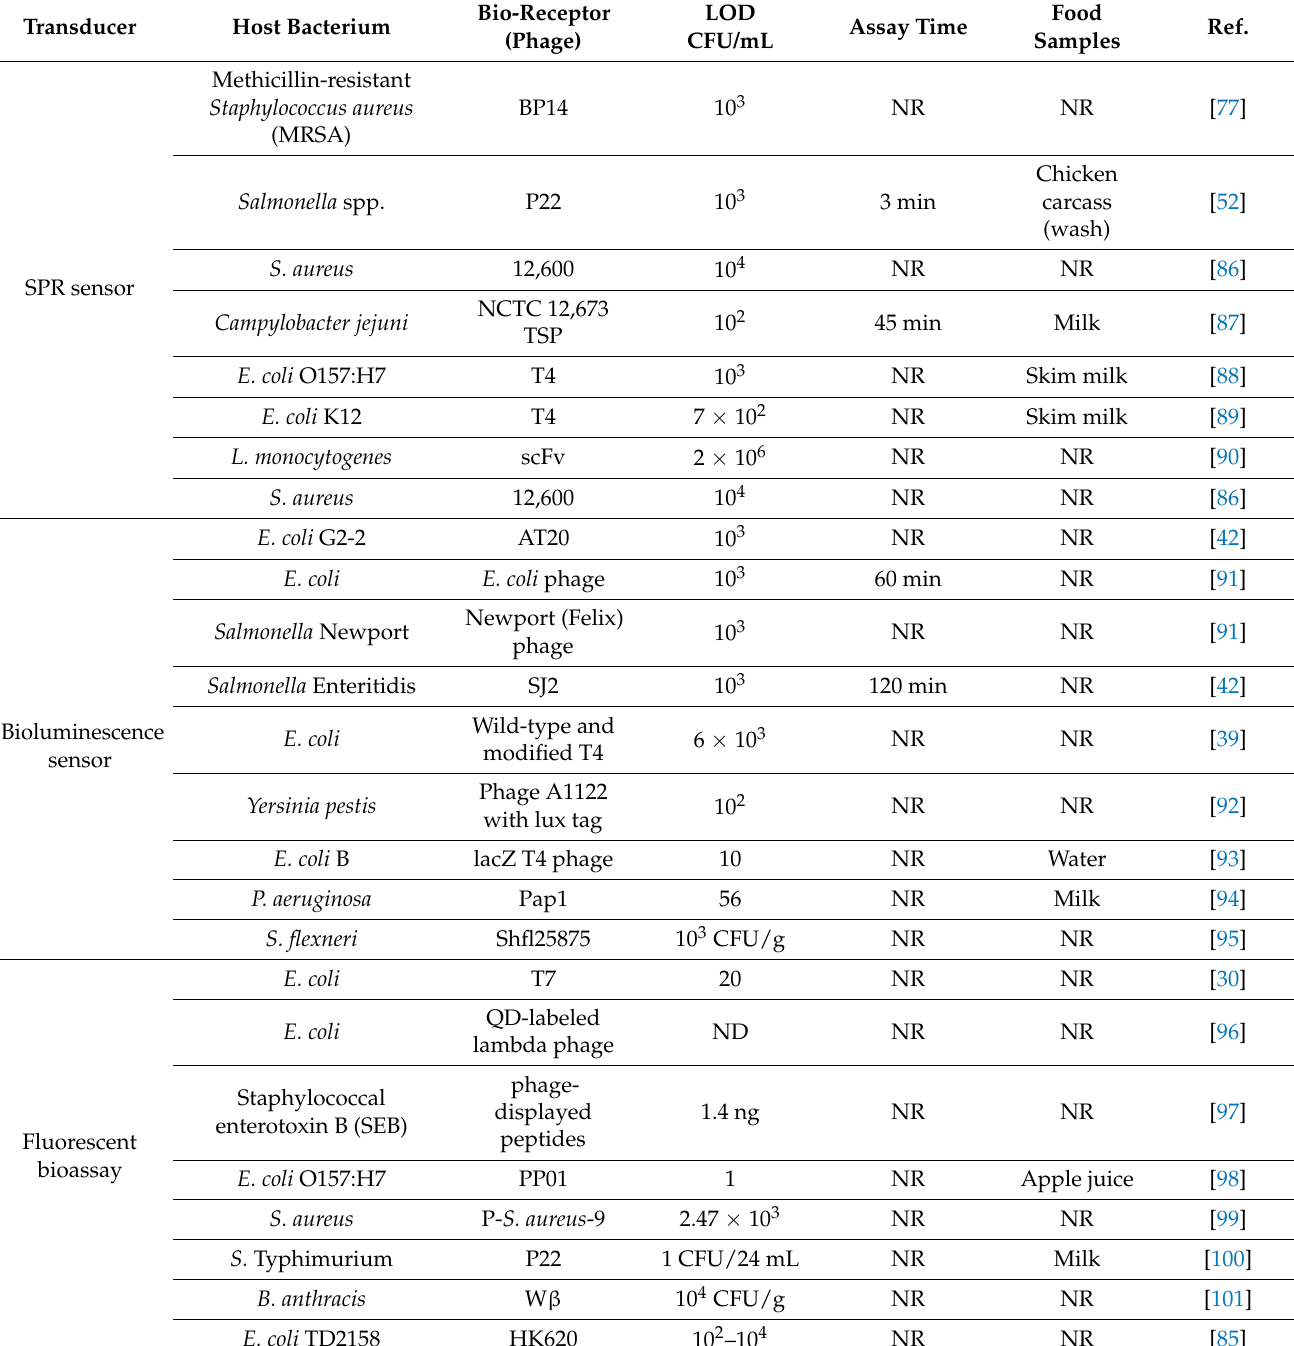
Table 1. Optical phage-based